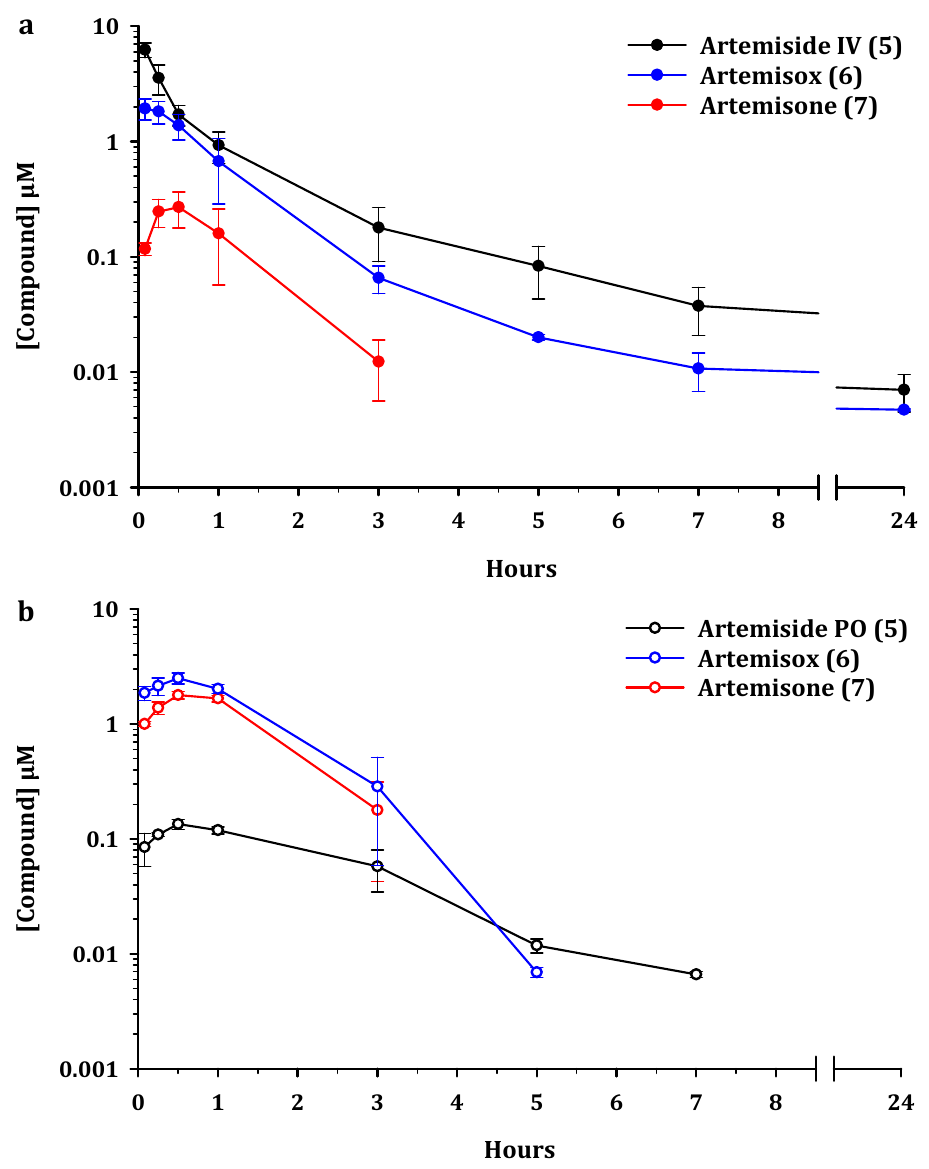
Figure 2. Circulating concentrations of artemiside 5 and its principal metabolites artemisox 6 and artemisone 7 after ( a ). intravenous ( iv ) administration of artemiside at 5 mg/kg and ( b ). oral ( po ) administration at 50 mg/kg to male C57/BL6 mice ( n = 3 for each group). All results are presented as mean ± standard deviation.